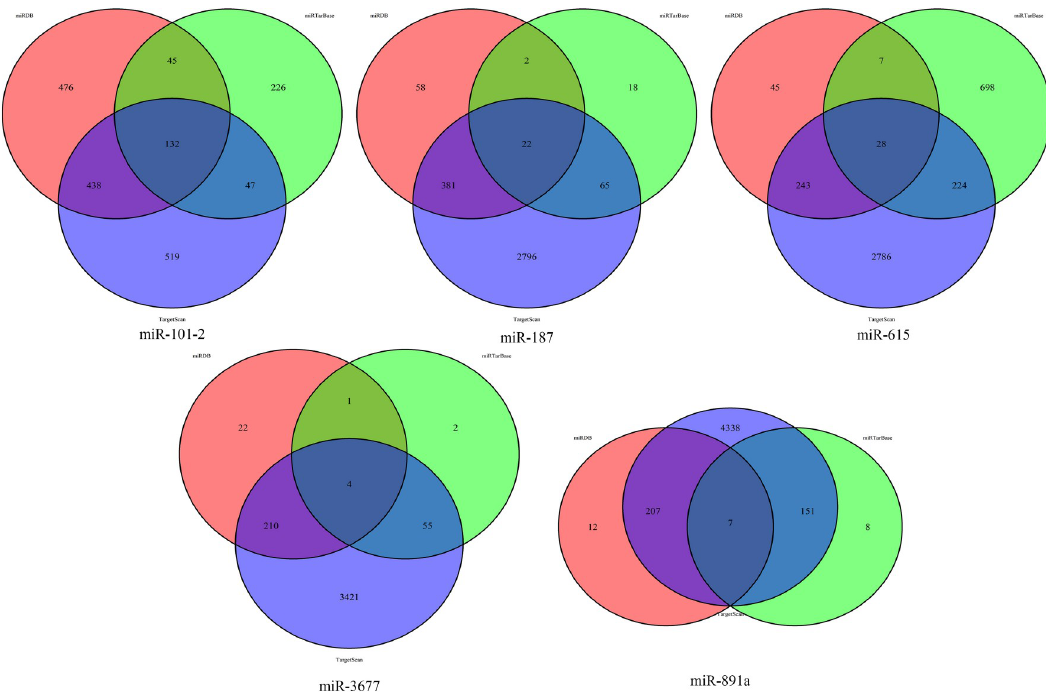
Fig 6. The overlapping target genes. The overlapping target genes were predicted using the TargetScan, miRDB, and miRTarBase online analysis tools.